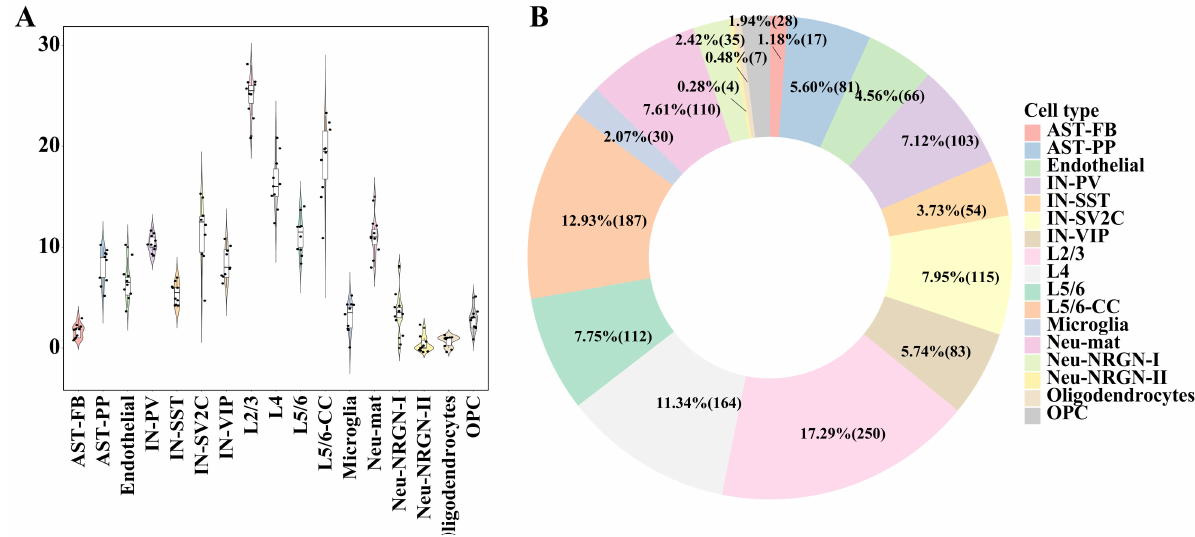
Figure 2. Distribution of the number of ASD-associated gene modules in each cell type. ( A ) Violin diagram of the number of ASD-associated gene modules obtained in each data partition for each cell type. Every dot denotes the gene modules’ number in each data partition. ( B ) The pie chart of the number of ASD-related gene modules. The pie chart percentage indicates the ratio of the gene modules’ number of each cell type to the total number of modules, followed by the modules’ number in